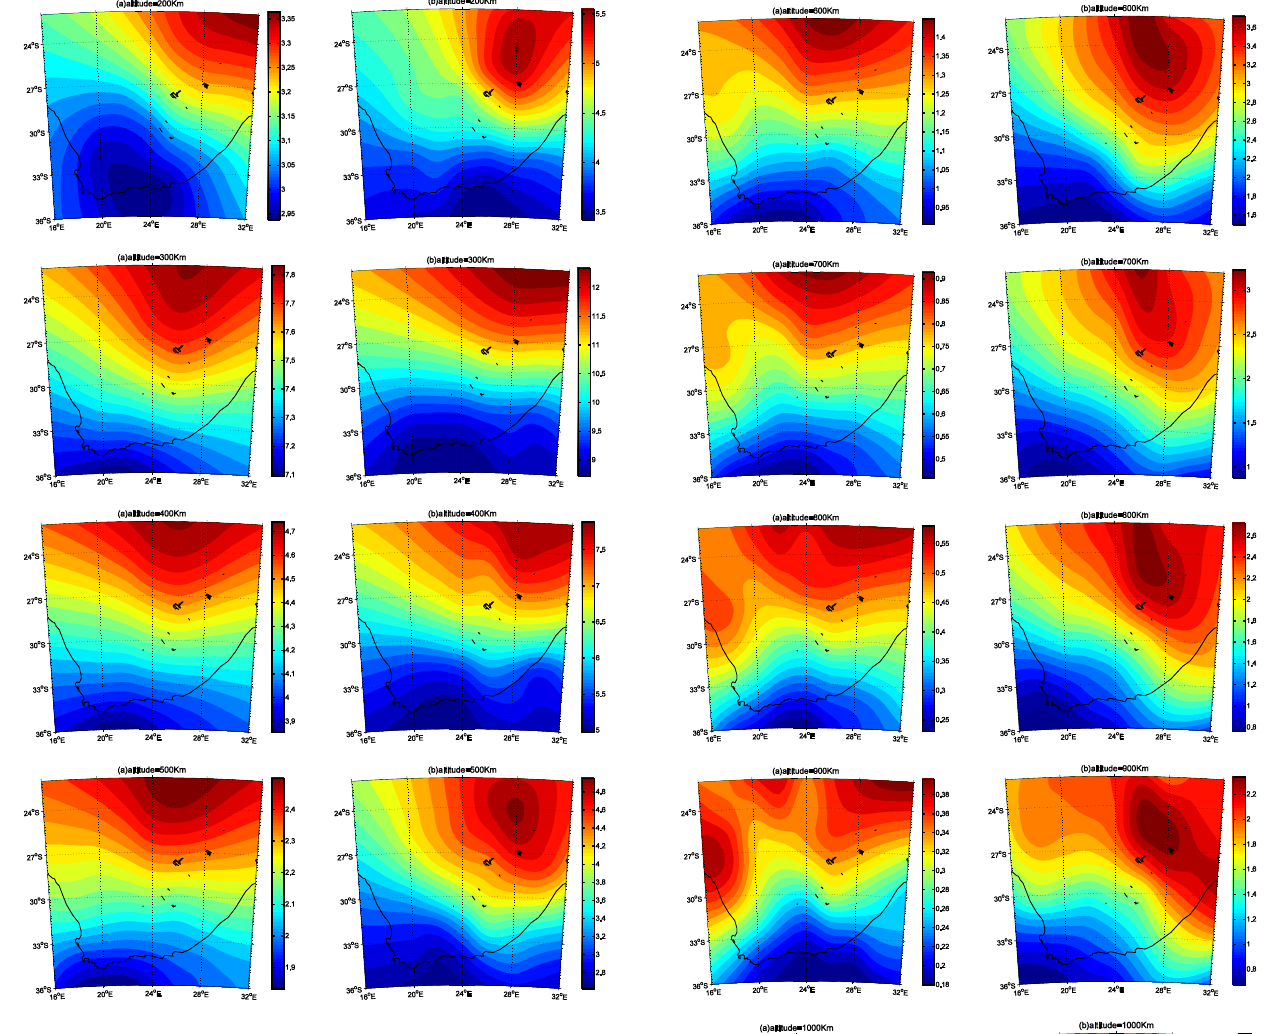
Fig. 3. Electron density at different altitudes at 10:00UT (13:00LT) on (a) 14, (b) 15 May 2005 (unit: 10 11 elm − 3 ) .